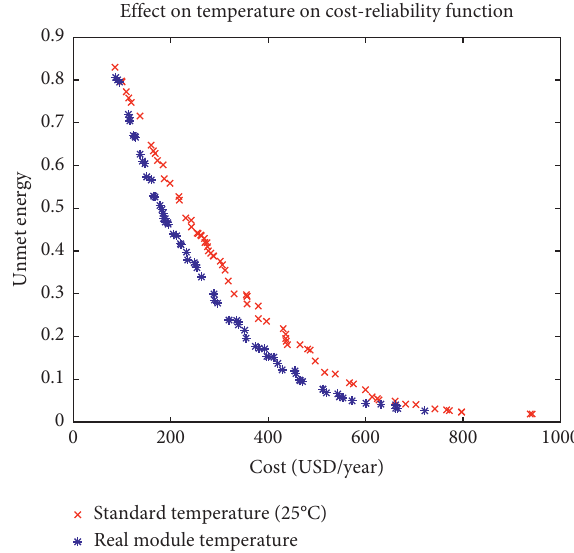
Figure 2: The effect of cold temperature on cost-reliability rela- tionship of the hybrid wind/solar energy system for a detached house of 5 people (PV panels tilt angle: 65 ° toward south; wind turbine hub height: 12m; battery type: Li-ion batteries; yearly consumption: 6300kWh).